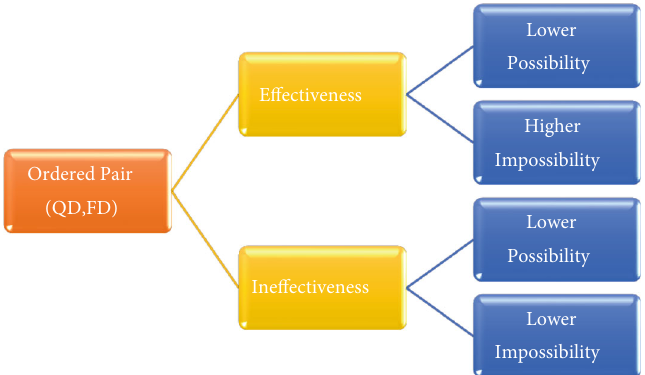
Figure 3: Impact of QD on FD.